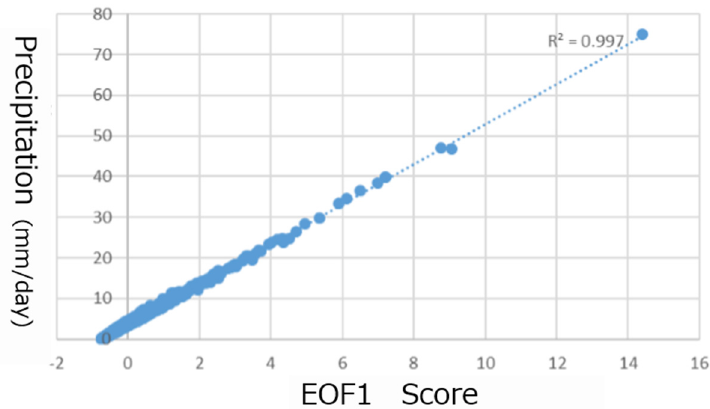
Figure 6. Scatter diagram between EOF1 score and daily averaged precipitation of the 36 grid points (Figure 3b). The dotted line indicates a regression line, and the determination coefficient is 0.997.